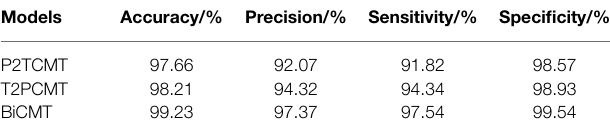
TABLE 7 | Comparison of cross-modal training results.